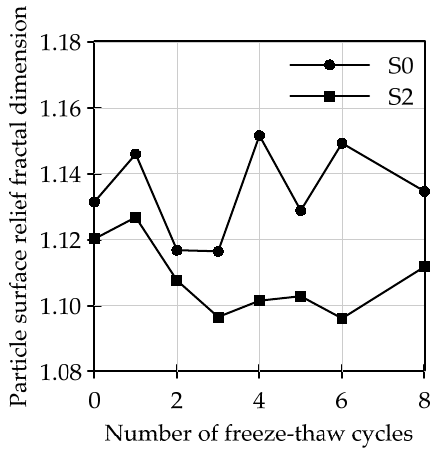
Figure 9. The curve of D pr versus F-T cycles.